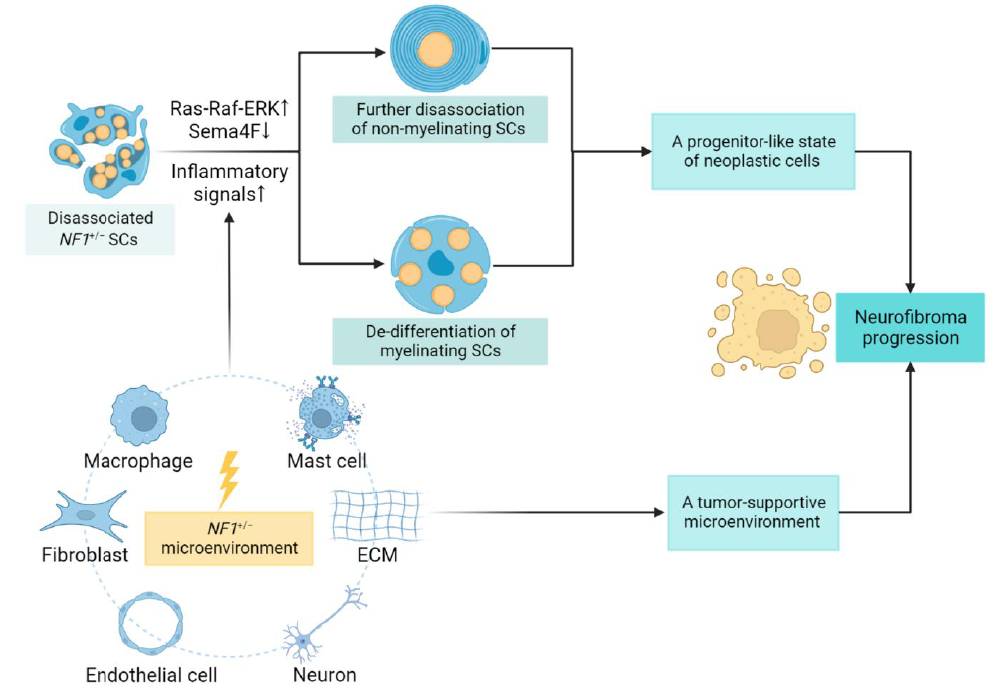
Figure 2. SC lineage shift and contributing factors in neurofibroma progression. The neoplastic SCs can rapidly de-differentiate to a progenitor-like state, disrupting SC–axonal interactions with tumor development. The underlying mechanism involves Ras-dependent downregulation of an SC surface protein, semaphorin 4F (Sema4F), together with elevated inflammatory signals, especially upon injury. Other environmental factors, including cellular and non-cellular components, further create a tumor-promoting microenvironment. The proliferative state of neoplastic cells and supportive tumor microenvironment combined to promote neurofibroma progression. ↑ : upregulation of signaling pathways; ↓ : downregulation in expression.